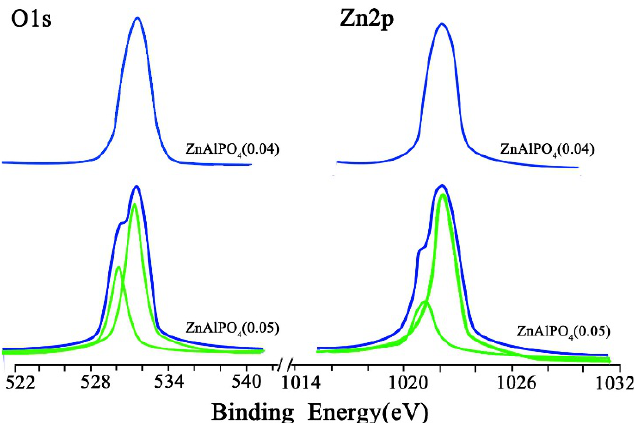
Figure 1. X-ray photoelectric spectroscopy (XPS) spectra of O1s and Zn2p from ZnAlPO 4 catalysts.